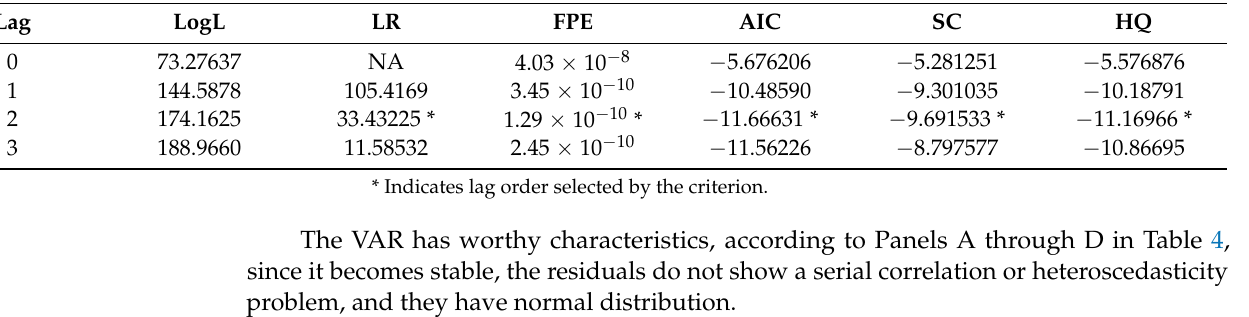
Table 3. Lag interval tests. Information Criteria